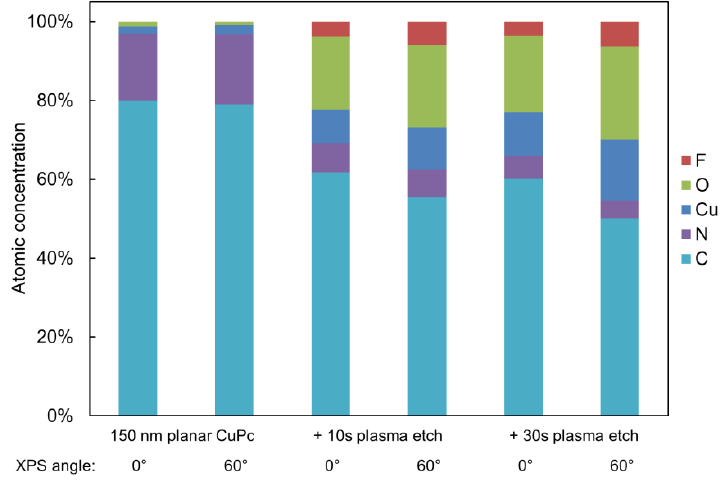
Figure 6. Changes to the surface composition of a planar CuPc film due to argon plasma